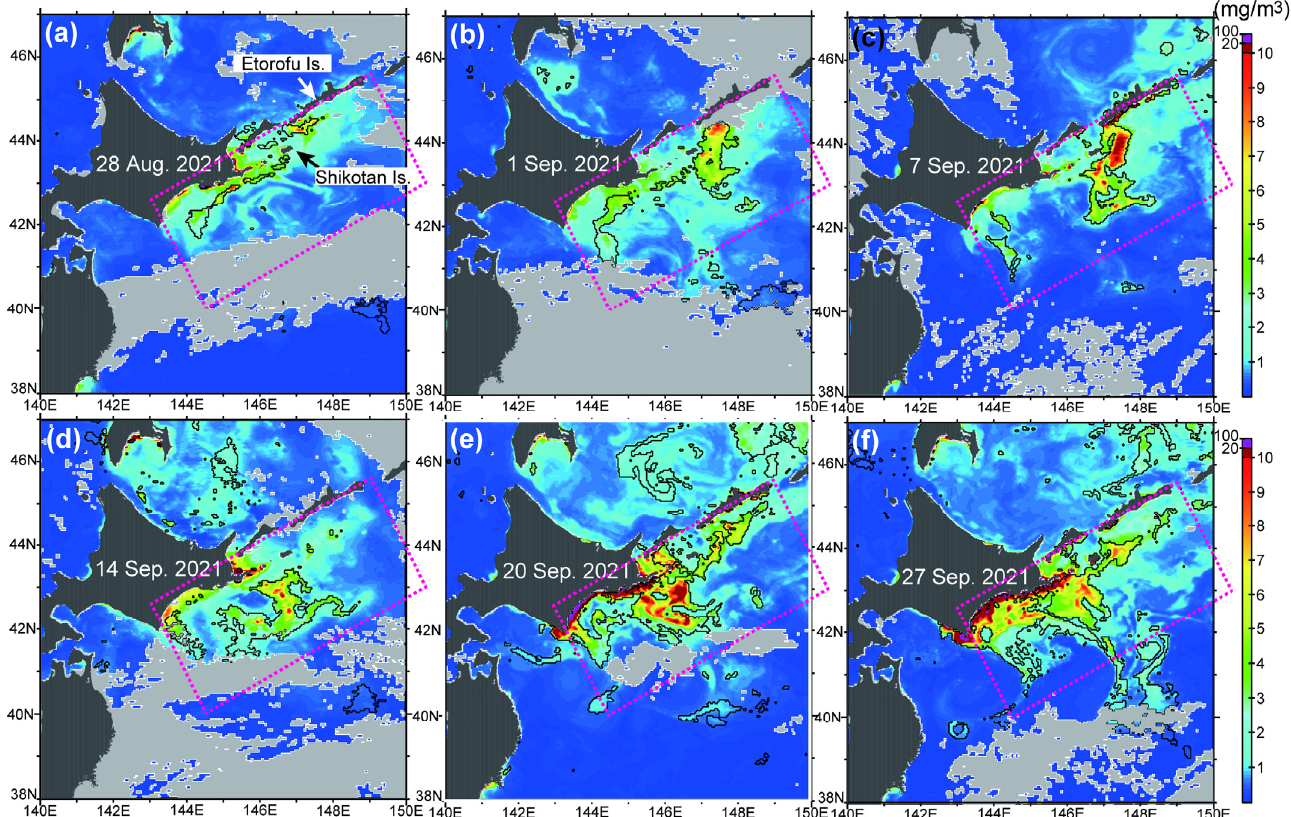
Figure 3. Distribution of daily satellite-derived chlorophyll concentrations (SCCs) on ( a ) 28 August, ( b ) 1 September, ( c ) 7 September, ( d ) 14 September, ( e ) 20 September, and ( f ) 27 September 2021, when there were few clouds (light-grey shading) over the study region. Inside of black polygons, the daily SCC exceeded the monthly mean plus 3 standard deviations for September 1998–2020 at each grid point. The pink dotted rectangle is referred to as the “focal region” throughout this study. SCCs were based on near-real-time L3 and reprocessed L4 products.